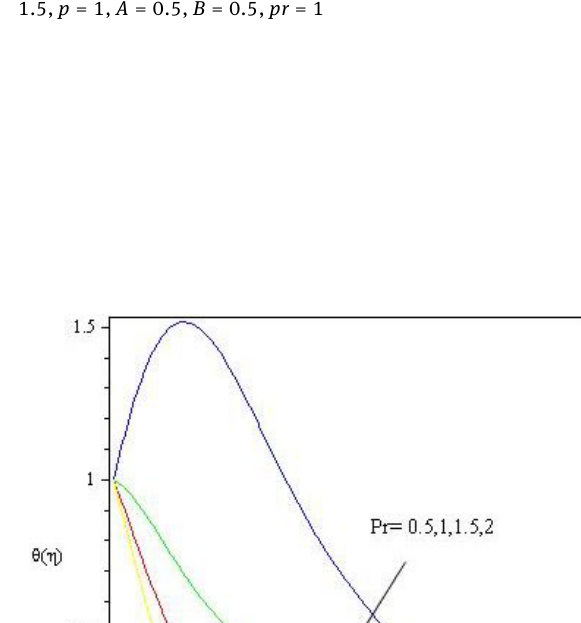
Fig. 15: Temperature profile for different values of M and n = 1.5,